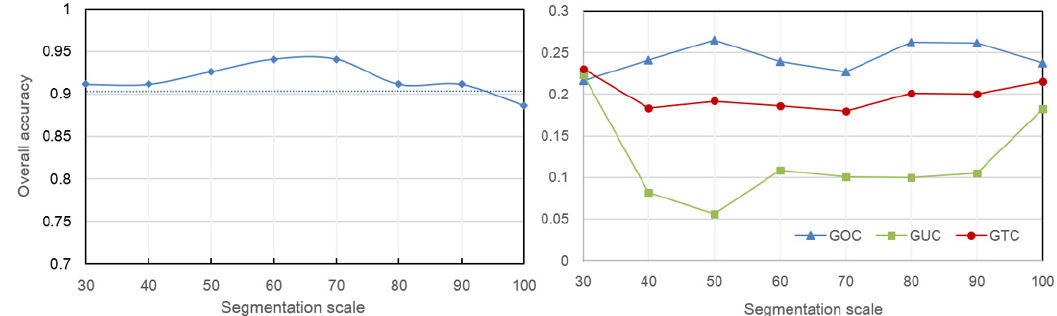
Figure 4. Effect of scale values on the attribute accuracies ( left ) and geometric errors ( right ) of tea object classifications. GOC, GUC, and GTC refer to global over-, under-, and total classification errors.